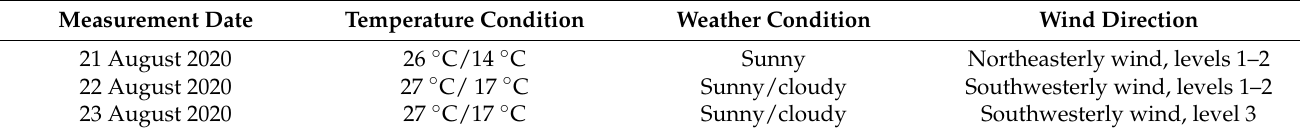
Figure 2. Site route and reference group location, A and B are both reference groups. Table 1. Weather information for Changchun from 21 to 23 August 2020.